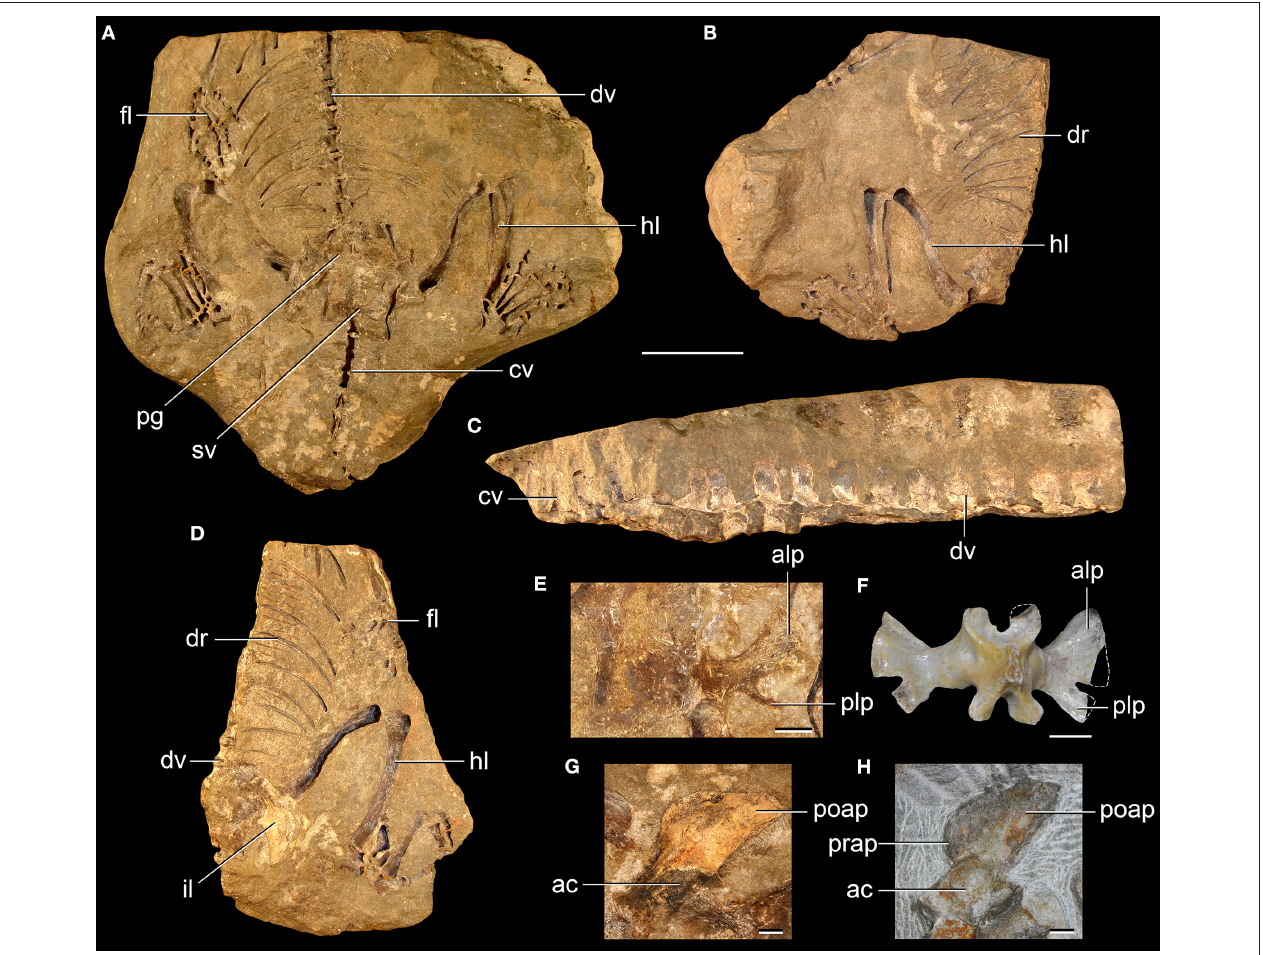
FIGURE 2 | Noteosuchus colletti from the Induan of South Africa. N. colletti (A-E,G) compared with selected bones of Mesosuchus browni (F, H) from the early Anisian of South Africa. Lower block (A) , upper right block (B) , and upper left block (C,D) , close-up of right second sacral rib in either dorsal or ventral view (E) , and close-up of left ilium in lateral view (G) of N. colletti (AM 3591, holotype); and second sacral vertebra and ribs in dorsal view (SAM-PK-6046) (F) and left ilium in lateral view (SAM-PK-7416) (H) of M. browni . Abbreviations: ac, acetabulum; alp, anterolateral process; cv, caudal vertebrae; dr, dorsal ribs; dv, dorsal vertebrae; fl, forelimb; hl hindlimb; il, ilium; poap, postacetabular process; prap, preacetabular process; pg, pelvic girdle; plp, posterolateral process; sv, sacral vertebrae. Scale bars equal 5cm in (A-D) and 5mm in (E-H)